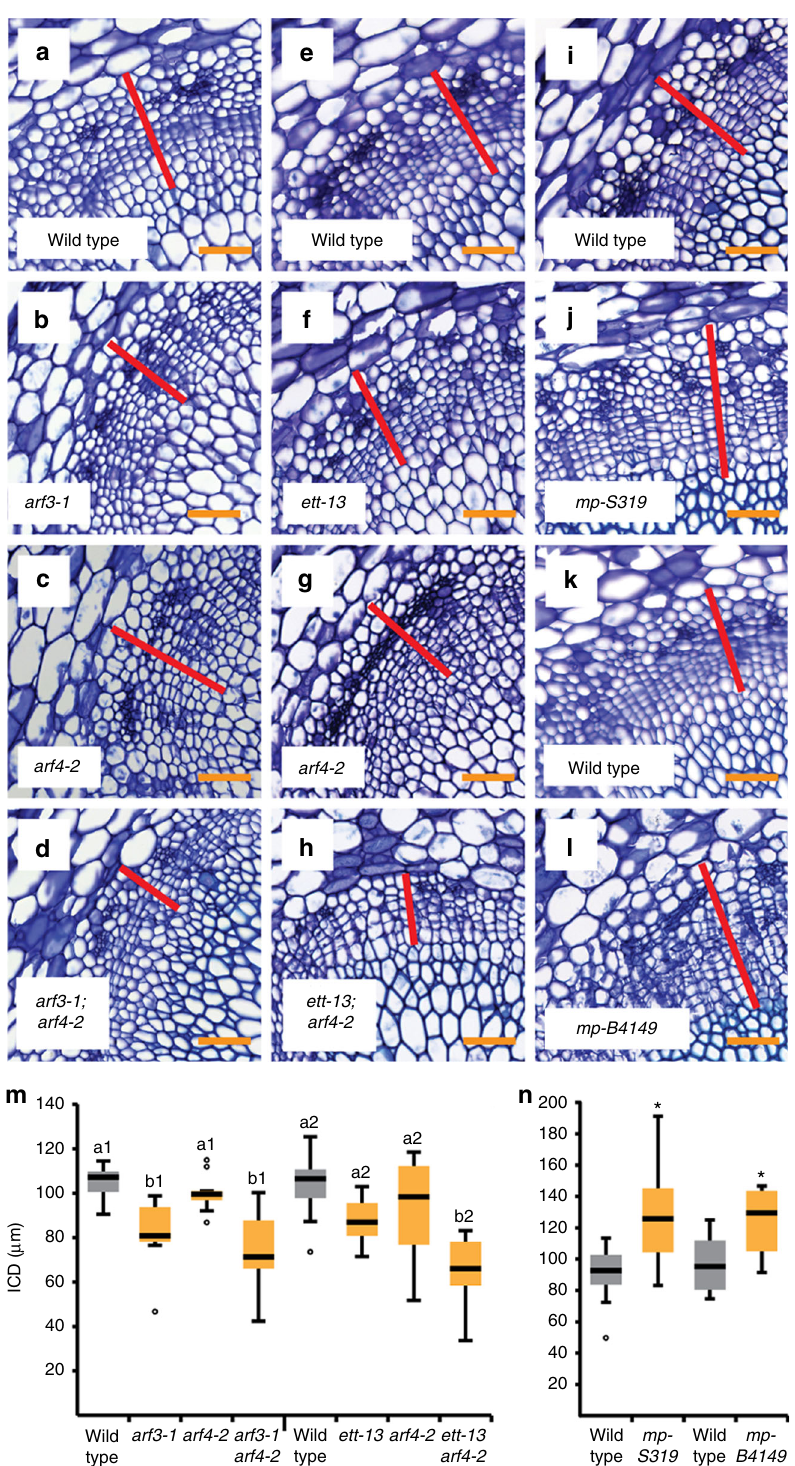
Fig. 3 ARF genes ful fi l opposite functions in cambium regulation. a – l Toluidine blue-stained cross-sections at the stem base of wild-type and arf single and multiple mutant plants. Genotypes are indicated. Interfascicular regions are shown and interfascicular cambium-derived tissues (ICD) are marked (red bar). Size bars represent 50 µ m. m , n Quanti fi cation of ICD tissues at the stem base of wild-type, arf3/4 single and double mutants ( m ) and arf5/mp mutant plants ( n ). Statistical groups indicated by letters were determined by one-way ANOVA with post hoc Bonferroni (CI 95%; Sample size n = 8 – 10) ( m ). Student ’ s T -test was performed comparing wild type and mp-S319 ( p = 0.003) and wild type and mp-B4149 ( p = 0.03), respectively (Sample sizes n = 4 – 12) ( n ). The T-bars that extend from the boxes (whiskers) are expected to include 95% of the data. Signi fi cance is indicated by